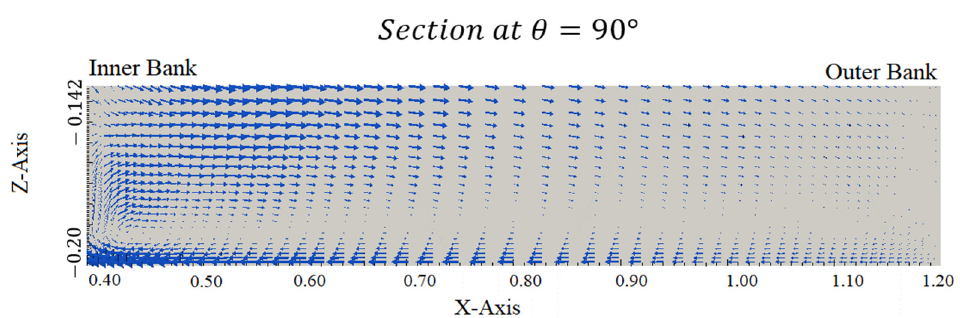
Figure 11. The velocity vectors at θ = 90° (Realizable k- ε ) .